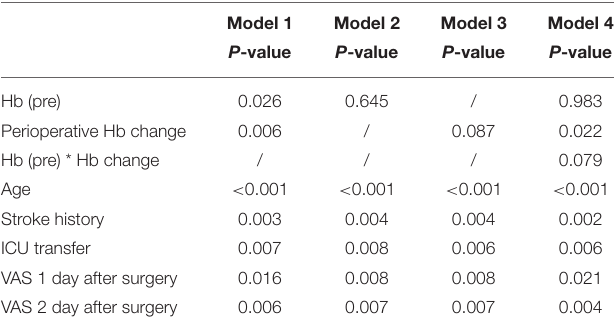
TABLE 4 | Different models of the logistic analysis of the independent risk factors ( p < 0.05) of